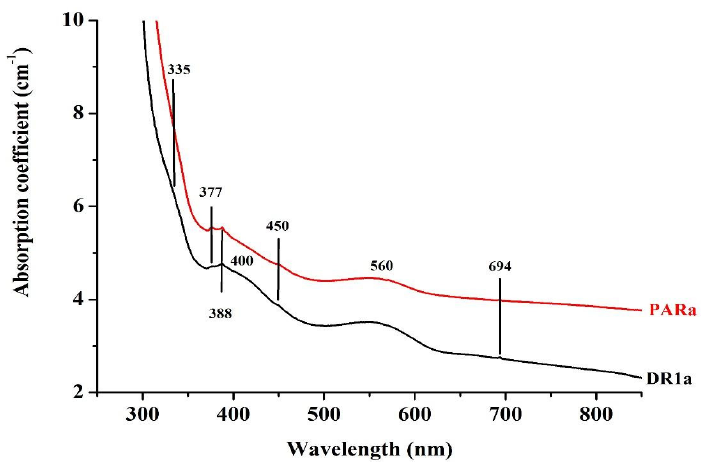
Figure 7. UV-Vis spectra of the samples DR1a (black trace) and PARa (red trace), both of pink color with DR1a being slightly red, from Paranesti (Drama). Figure 8 exhibits the absorption spectra of the light pink, slightly purple, sapphire GO5a and the blue sapphire GORa from Gorgona. Sample GO5a shows the same absorption bands in the visible range as the samples presented in Figure 7, with the chromium related bands situated at 400 and 560 nm and the iron related narrow bands situated at 377, 388 and 450 nm having lower intensity. Chromium related bands do not appear in the spectrum of the blue colored GORa sample; only the Fe +3 related bands at 377, 388 and 450 nm. Additionally, a broad absorption from 500 to 750 nm is observed with apparent maxima at around 580 nm and another at around 700 nm. These bands are responsible for the blue color and are related to intervalence charge-transfer by Fe 2+ -Ti +4 [2,41–45]. The cut off for the sample GO5a is at around 310 nm and for the sample GORa at around 295 nm. The latter is also presenting a shoulder at around 325 nm.